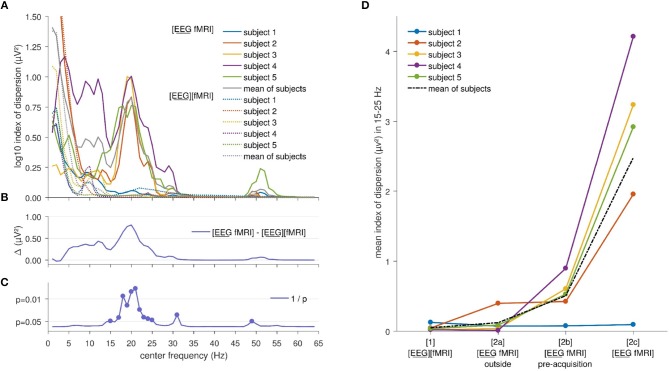
Electroencephalography (EEG) analysis: (A) Comparison of the logarithm (base 10) of the index of dispersion over all electrodes of the squared amplitude of the fast Fourier transform (FFT) between the separately ([EEG][fMRI]) and simultaneously ([EEG fMRI]) recorded EEG during the task, per frequency range. For every data point the mean squared amplitude of the FFT for a frequency interval of 2 Hz around the center frequency was calculated. (B) Mean difference Δ of the logarithm (base 10) of the index of dispersion of the squared amplitude of the FFT between the separately ([EEG][fMRI]) and simultaneously ([EEG fMRI]) recorded EEG. (C) Uncorrected p values as function of frequency of the difference shown in the previous panels. (D) Mean index of dispersion in the interval 15–25 Hz for the different recording conditions.